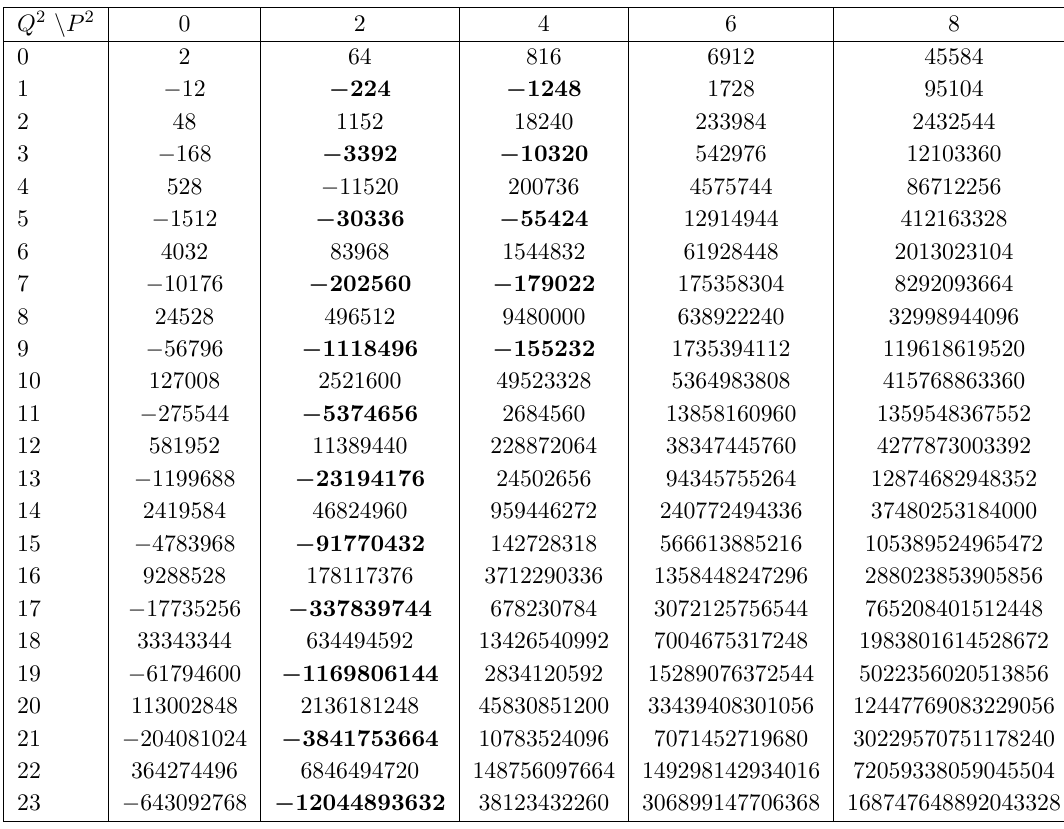
Table 17 . The index d ( Q; P ) for the Z 2 toroidal orbifold some low lying values of Q 2 , P 2 with Q (cid:1) P =